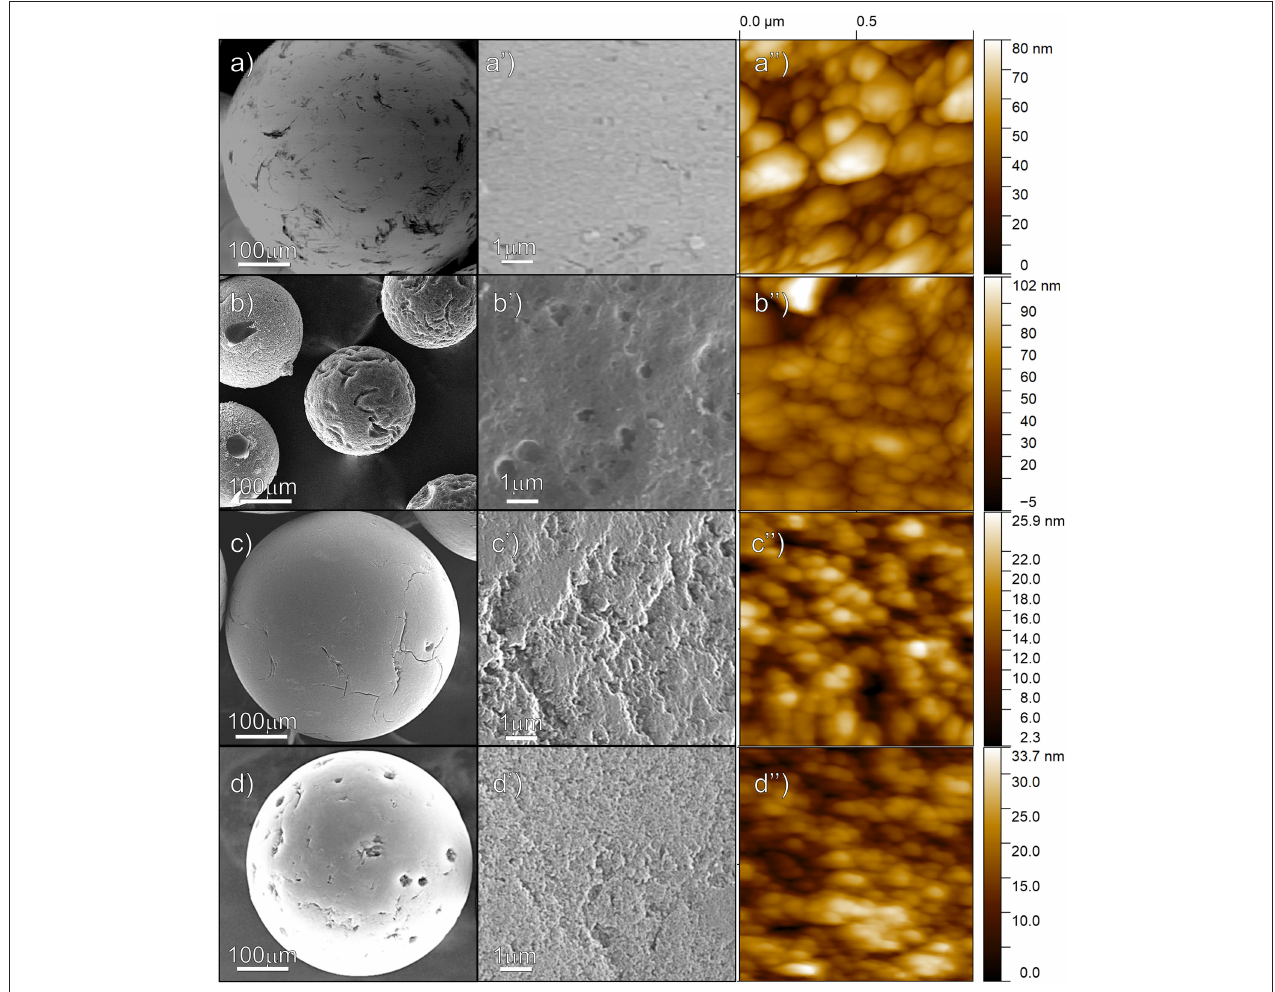
FIGURE 2 | Low-resolution, higher resolution SEM and AFM images of the surface of the microspheres: raw copolymer (a,a ′ ,a ′′ ) ; pyrolyzed PS-co-DVB (b,b ′ ,b ′′ ) ; ZnCl 2 -embedded copolymer (c,c ′ ,c ′′ ); and ZnCl 2 -carbon microspheres after impregnation with Fe nitrate solution and thermal treatment at 800 ◦ C (d,d ′ ,d ′′ )